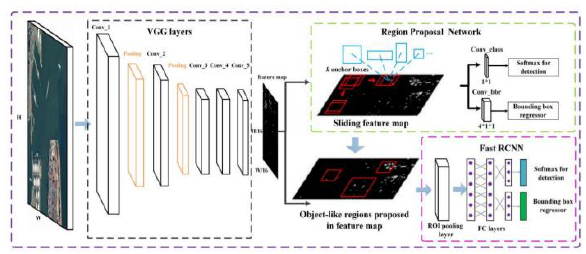
Figure 3 . The architecture of Faster R-CNN (Deng et al.,